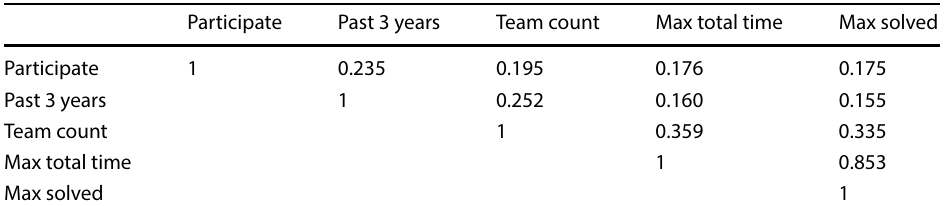
Fig. 2 Return rate as a func- tion of the number of